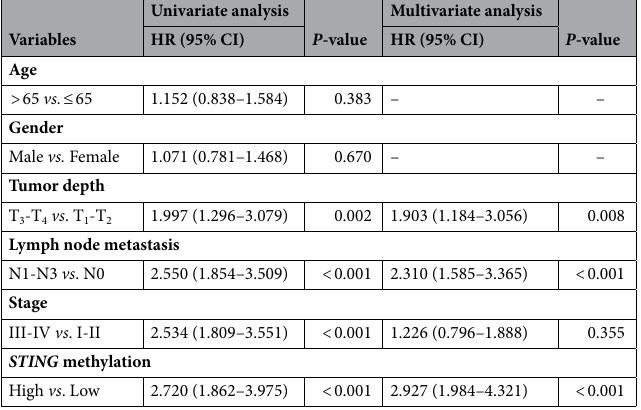
Table 1. Univariate and multivariate analysis of the prognostic value of clinical factors and STING methylation regarding OS in TCGA LUAD patients.